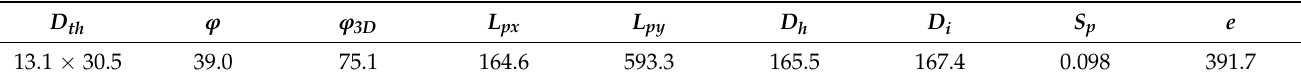
Figure 2. Detail of the IPS under study: ( a ) Microscope image of the insect-proof screen (IPS) under analysis (density: 13 × 30 threads·cm − 2 ), and ( b ) Computational reconstruction of the 3D shape using Poro3D software [26], where warp threads are shown in red color, and the weft threads in blue color. Table 1. Relevant geometric parameters of the insect-proof screen (IPS): Density of threads ( D th , [threads cm − 2 ]), porosity ( φ , [%]), volumetric porosity ( φ 3D , [%]), separation of the warp threads ( L px ), separation of the weft threads ( L py ); average diameter of threads ( D h ), inner diameter of the mesh pore ( D i ), average surface of the pore ( S p , [mm 2 ]), thickness of the screen ( e , [µm]). Lenghts are given in micrometers.